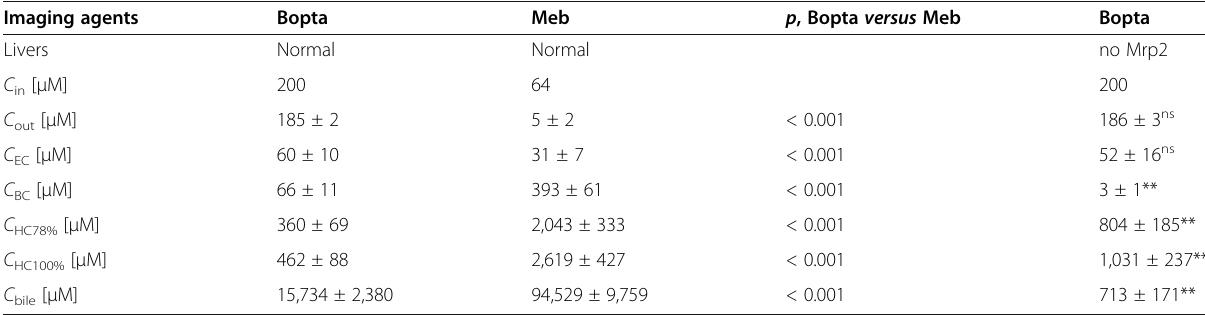
15,734 ± 2,380 713 ± 171** Statistics between normal livers and livers lacking Mrp2 perfused with Bopta (column 2 versus column 5) are nonsignificant (ns) and p < 0.001 (**). C EC Concentration in extracellular space, C BC Concentration in bile canaliculi detected by the counter, C bile In situ concentration in bile canaliculi and common bile duct, C HC78% Concentration in hepatocytes detected by the counter, C HC100% In situ hepatocyte